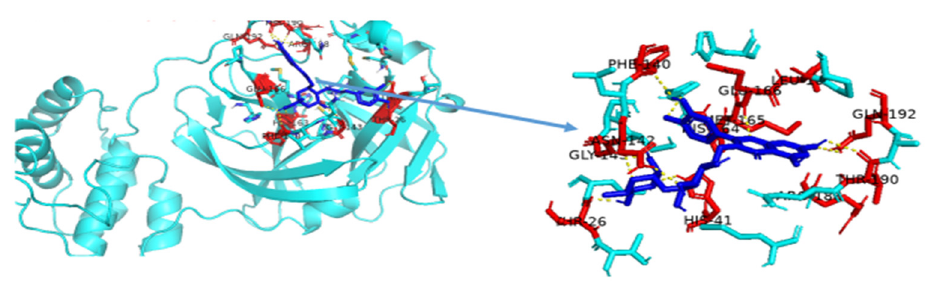
Figure 6. Binding of rutin to Mpro. Cyan-colored cartoon structure is Mpro and blue-colored stick structure is the ligand, rutin. Additionally, red-colored amino acid residues are involved in polar interactions with rutin.